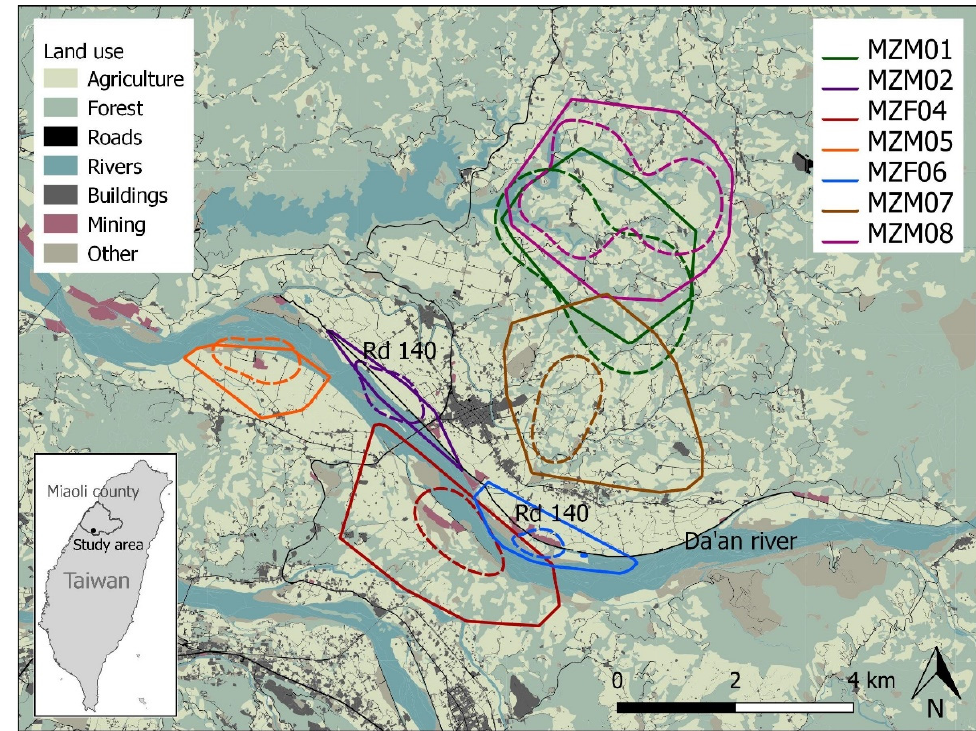
Figure 1. Map of the study area. Land use types within the study area and home range sizes (95% minimum convex polygons (MCPs) with a stationary arithmetic mean = solid line) and core area sizes (50% fixed kernels (FKs) with h ref = dashed line) for our radio-tracked leopard cats (excluding the maternal